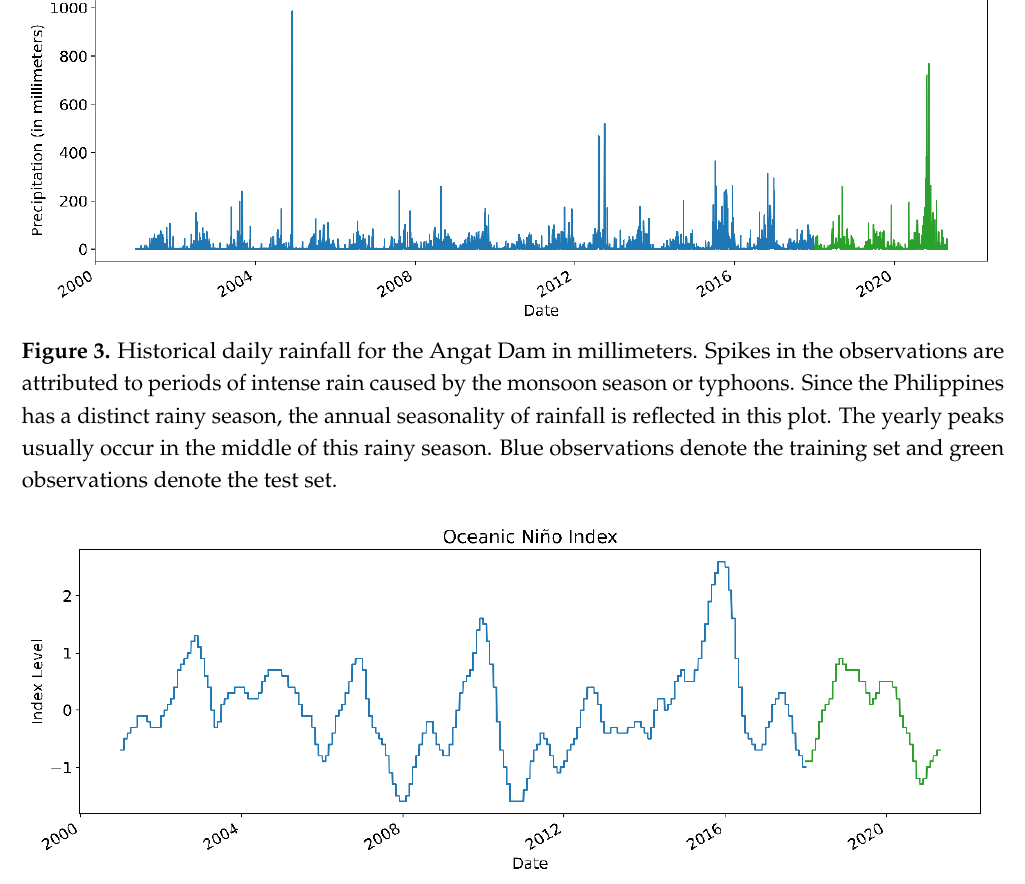
Figure 4. Oceanic Niño Index. The index is used to monitor the El Niño-Southern Oscillation and is calculated by averaging sea surface temperature anomalies in an area of the east-central equatorial Pacific Ocean. Monthly observations are transformed to daily frequency using a naïve interpolation. Blue observations denote the training set and green observations denote the test set. Data obtained from